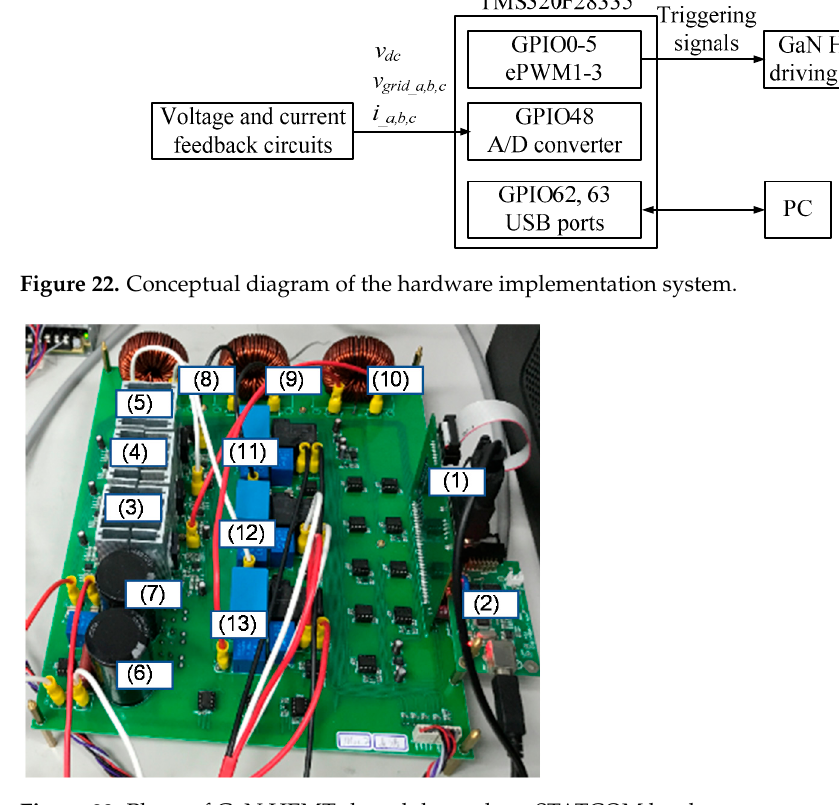
Figure 23. Photo of GaN HEMTs-based three-phase STATCOM hardware prototype. Table 5. Devices in Figure 23.